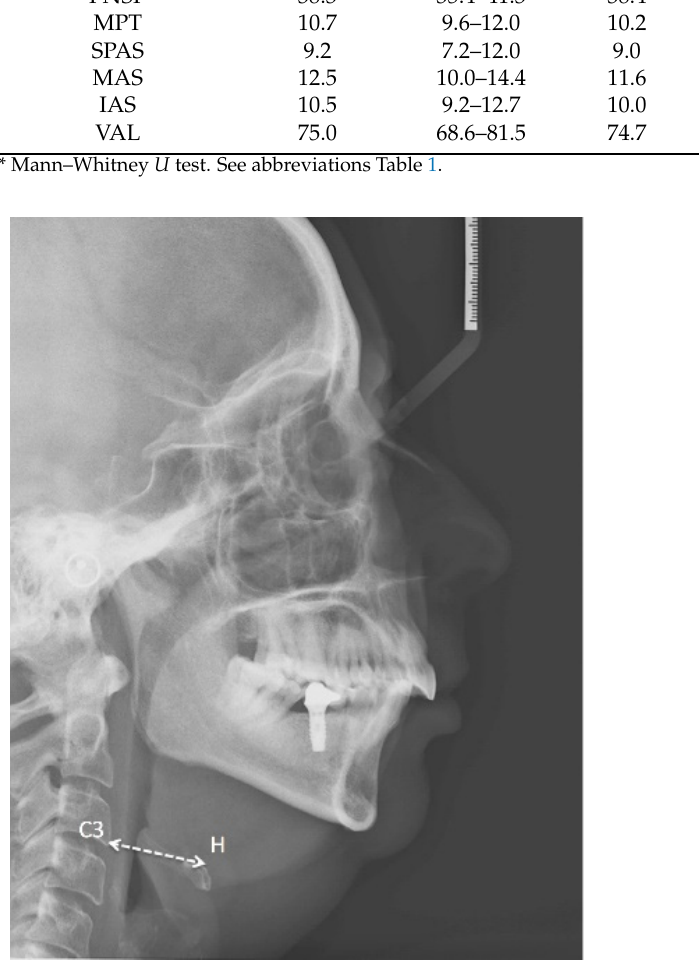
Figure 5. Lateral neck X-ray of one of our patients showing Hyoid-C3 vertebra distance.